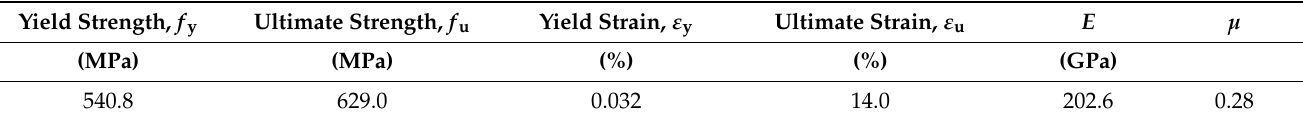
Table 2. Tested material properties of the Q460C steel.